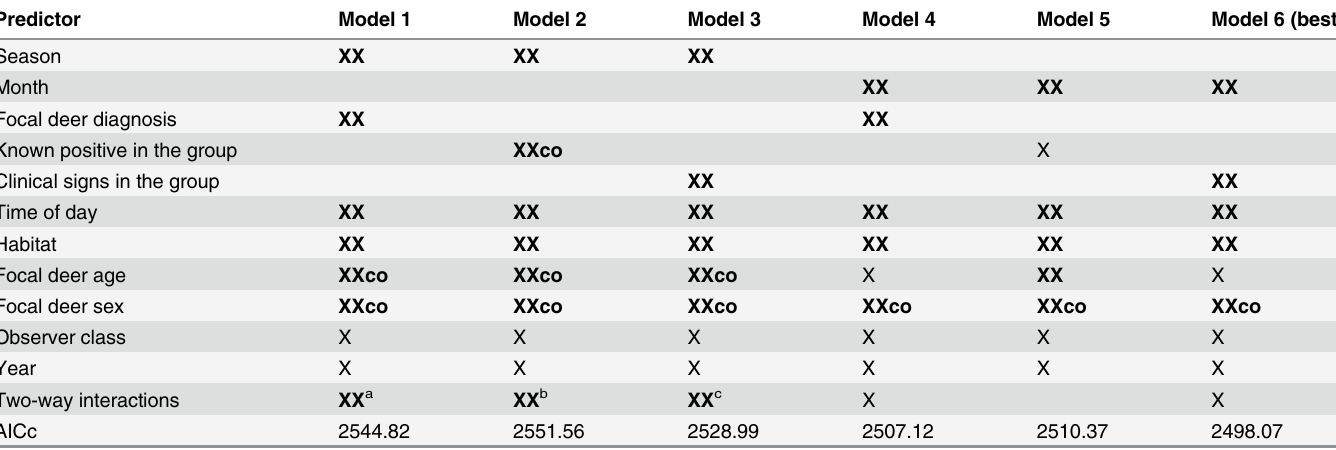
Table 2. Competing models to predict group occurrence.